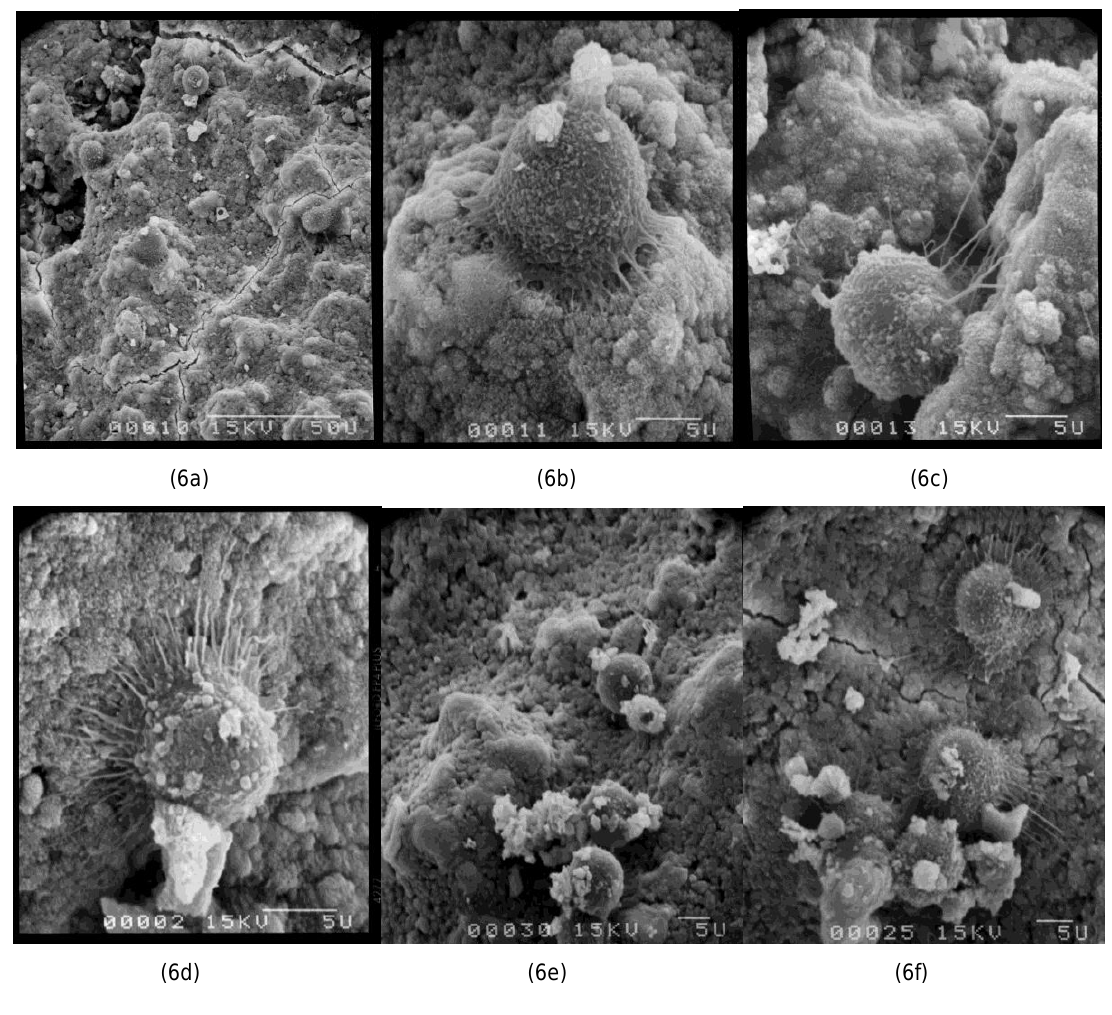
Figure 6. Morphology of osteoblasts at 24 h at the surface of cement tablets. Bar = 5 microns, except for 6a, 50 microns. ( a , b , c ) SE16P; ( d ) SE11S; ( e ) M68EC; ( f ) No